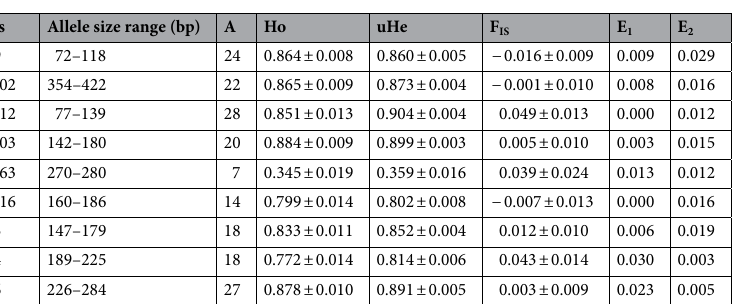
Table 1. Summary of allelic information across all plots. Number of alleles per locus (A), observed heterozygosity (Ho), unbiased expected heterozygosity (uHe) and inbreeding coefficient (F IS ). Allelic dropout (E 1 ) and false allele rates (E 2 ).